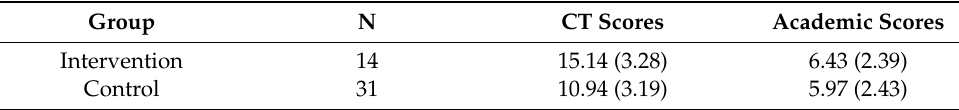
Table 2. CT and academic achievement average